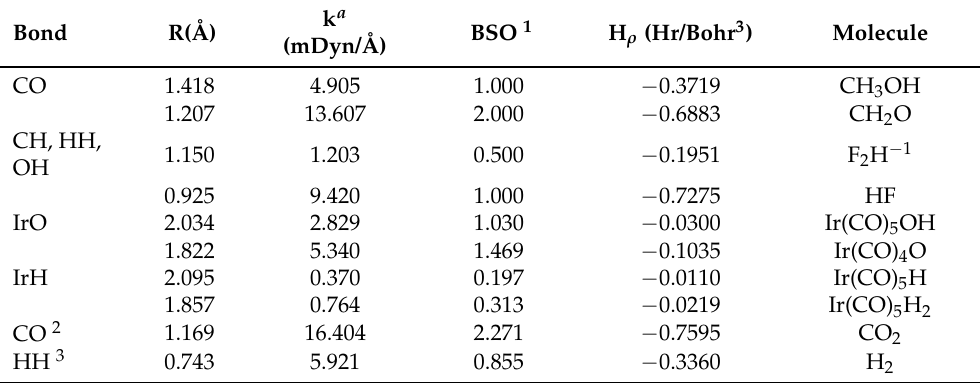
Table 1. Bond length R, local mode force constant k a , bond strength order BSO, and energy density H ρ evaluated at the bond critical point ρ ( r ) of the reference bonds and reference molecules used in our study. B3LYP/6-31G(d,p)/SDD(Ir) level of